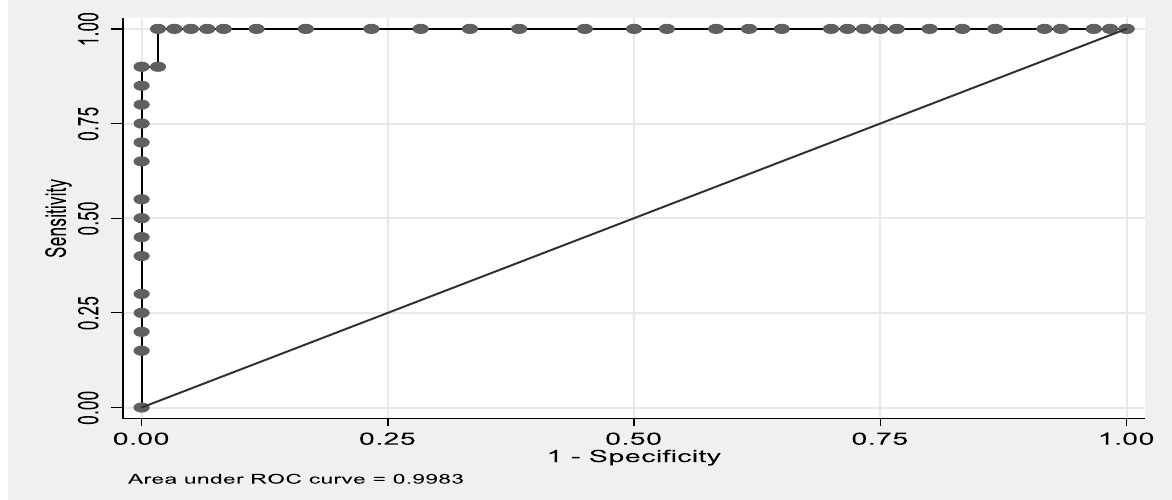
Fig. 5 ROC curve for the discriminatory power of FABP in the differentiation between macroalbuminuria vs normal